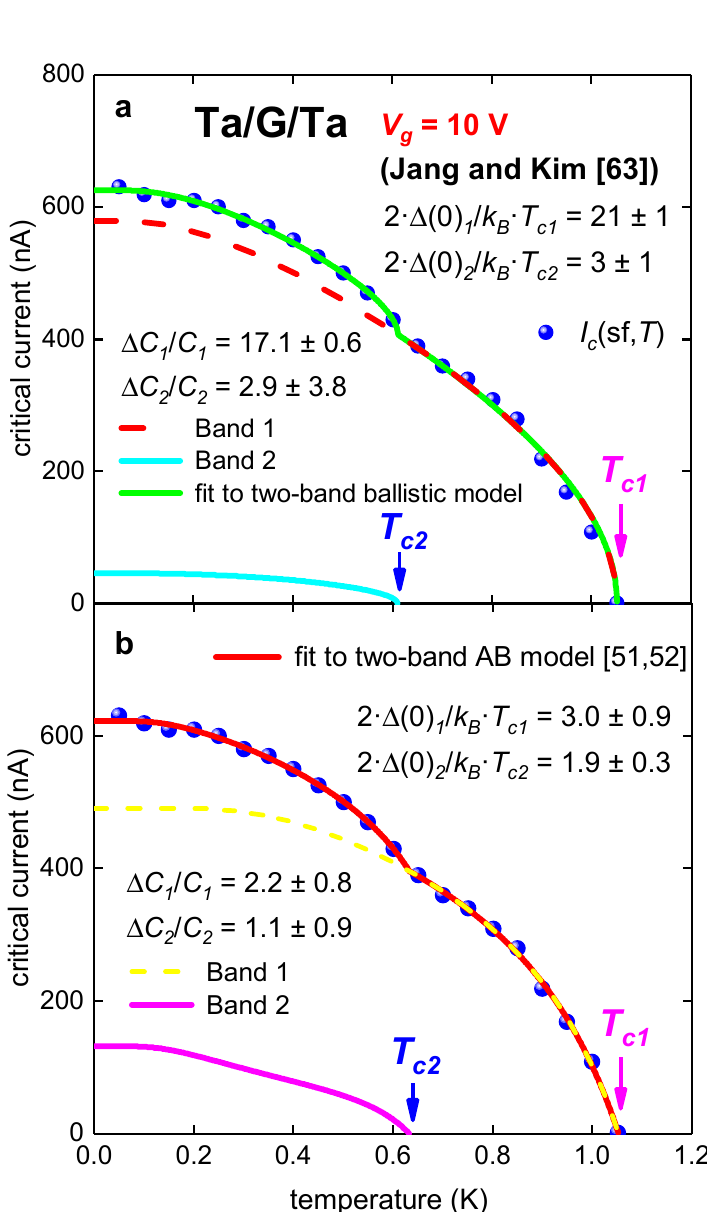
Figure 2. Experimental I c (sf, T ) for Ta / G / Ta junction (Device 1) at gate voltage of V g = 10 V [63] and data fits to two-band ballistic model (Equation (8), Panel a) and two-band modified AB model (Equation (5), Panel b). ( a ) Ballistic model, fit quality is R = 0.9978; ( b ) modified AB model [51,52]. Derived parameters: R n1 = 429 ± 184 Ω , R n2 = 603 ± 209 Ω , fit quality is R = 0.9994.